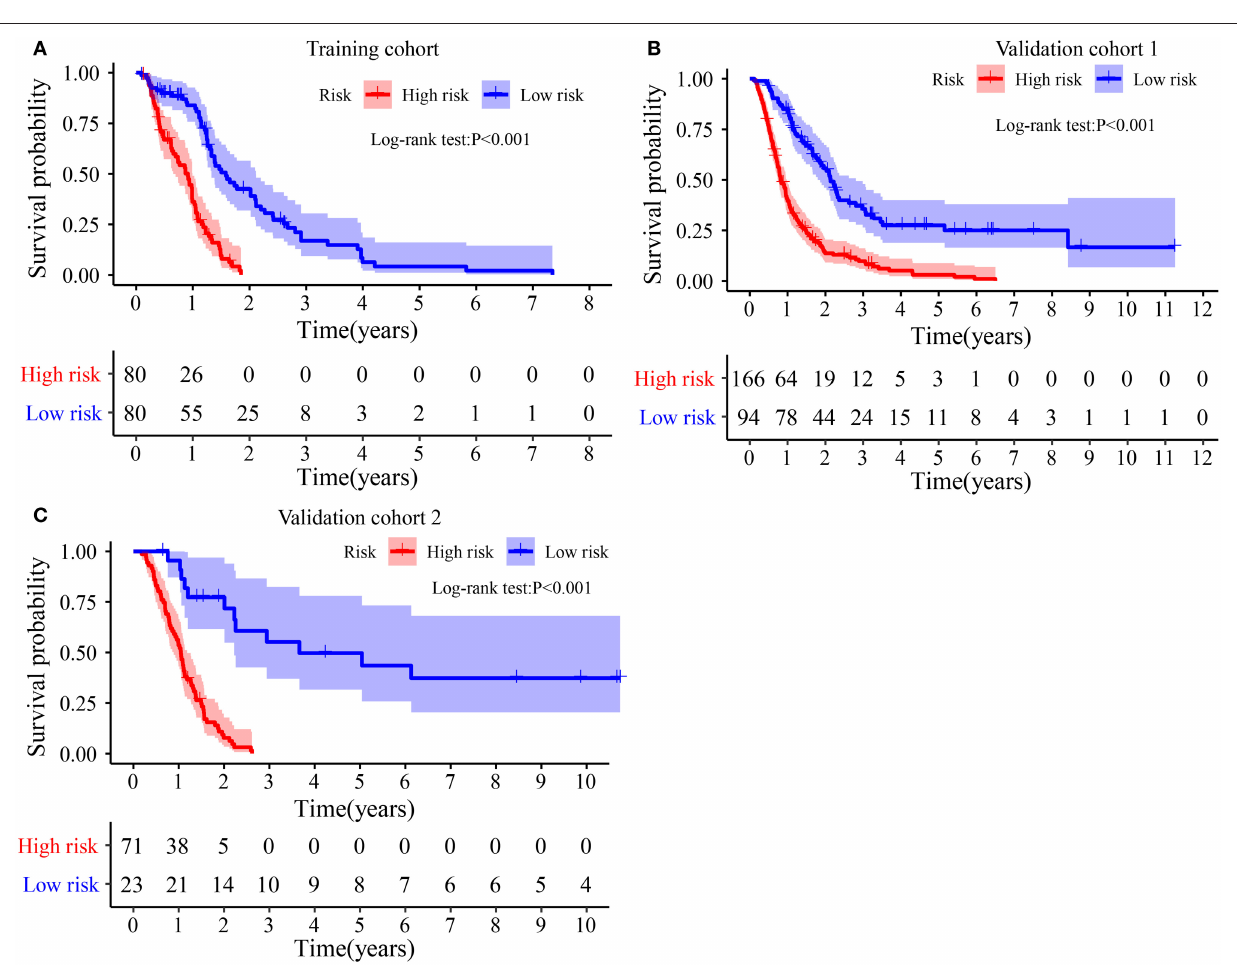
addition, the risk scores of patients aged ≥ 50 were significantly increased ( p = 0.034, Figure 6B ). An analogous phenomenon was observed in patients with mesenchymal GBM ( p = 0.004,